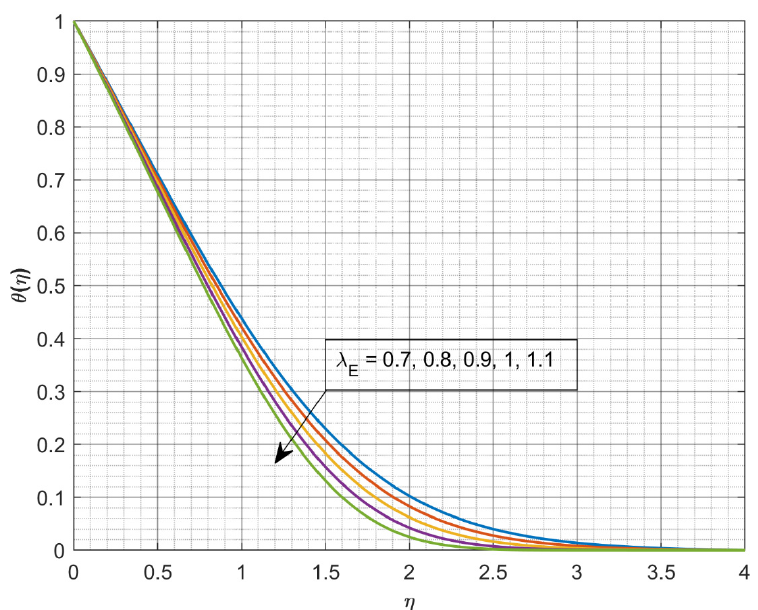
Figure 6. Influence of 𝜆 (cid:3006) on 𝜃(𝜂) .